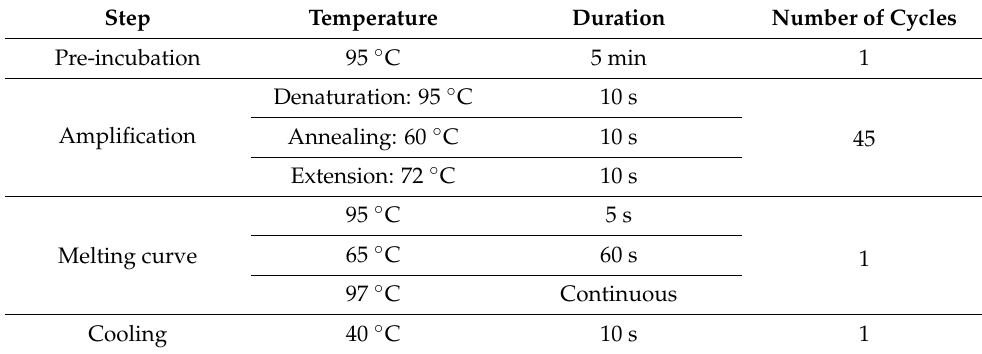
Table A2. Quantitative PCR reaction protocol used in the study.